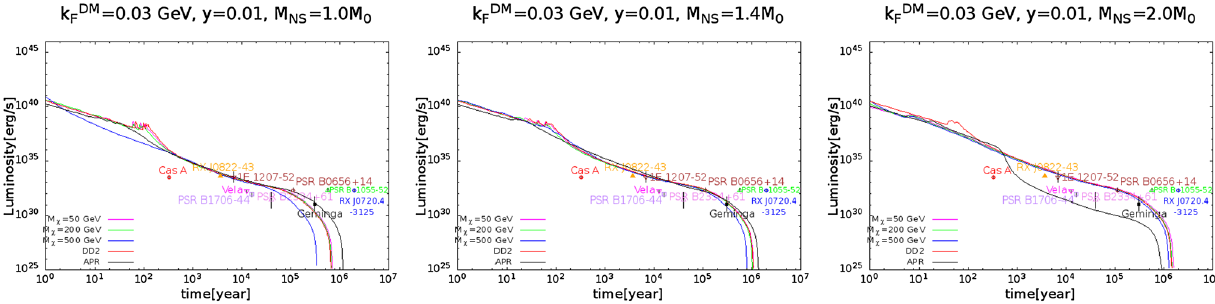
Fig. 11 Same as in Fig. 10 but for k DM